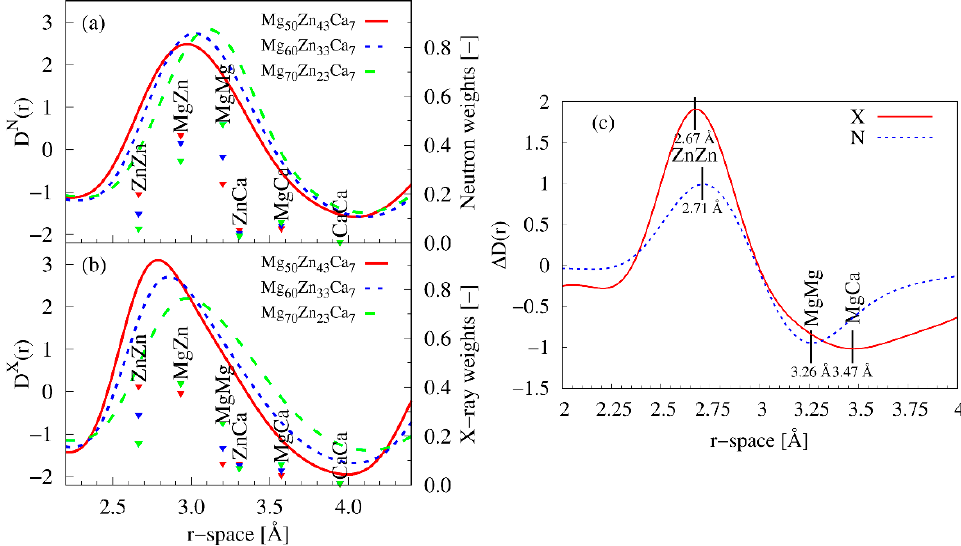
Figure 3. The first maxima of ( a ) neutron and ( b ) X-ray reduced total pair distribution functions corresponding to the first coordination shells of Mg 50 Zn4 3 Ca 7 , Mg 60 Zn 33 Ca 7 , and Mg 70 Zn 23 Ca 7 together with neutron and X-ray weights (at Q = 0 Å) of the partial reduced pair distribution functions. ( c ) The difference curve, Δ D ( r ), between the total reduced pair distribution functions of Mg 60 Zn 33 Ca 7 and Mg 50 Zn 43 Ca 7 for neutrons (N) and X-rays (X) in the range of distances of the first coordination shell.